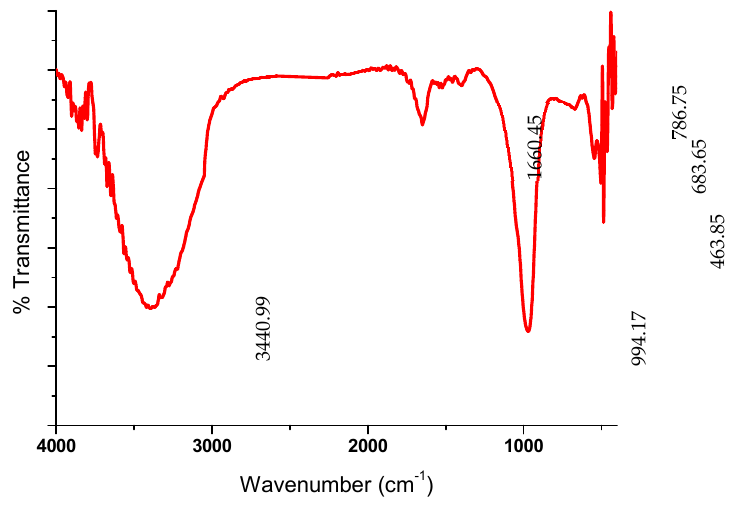
Figure 2. FT-IR spectra of 4AZW.